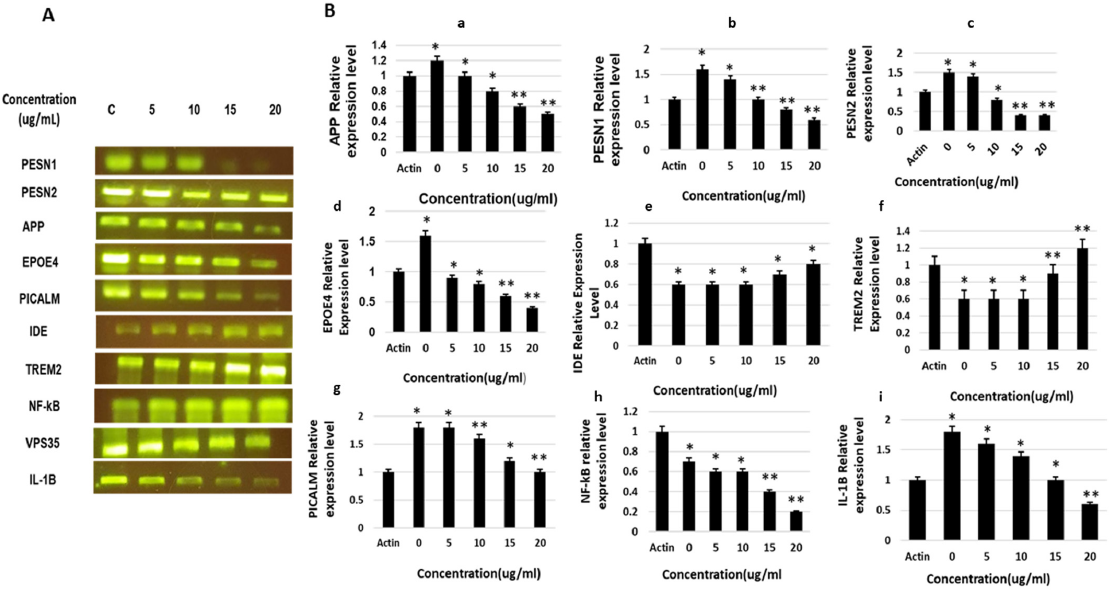
Figure 5. The gene expression of APP, PESN1, PESN2, EPOE4, IDE, VPS35, PCALM, NF-kB, and IL-1B, as under the influence of theasaponin E1, determined by RT-qPCR. ( A ) Expression of APP, PESN1, PESN2, EPOE4, IDE, VPS35, PCALM, NF-kB, and IL-1B, as determined by reverse transcription quantitative PCR, visualized by PCR products bands on membrane after gel electrophoresis. ( B ) Relative mRNA expression levels of various genes. ( a ) Relative protein expression levels of APP. ( b ) Relative mRNA expression level of PESN1. ( c ) Relative mRNA expression level of PESN2. ( d ) Relative mRNA expression level of EPOE4. ( e ) Relative mRNA expression level of IDE. ( f ) Relative mRNA expression levels of VPS35. ( g ) Relative mRNA expression levels of PCALM. ( h ) Relative mRNA expression levels of NF-kB. ( i ) Relative mRNA expression levels of IL-1B. Data are shown as mean ± SEM analyzed with one-way ANOVA ( n = 3). Data considered statistically significant at p < 0.05 (* p < 0.05; ** p < 0.01).